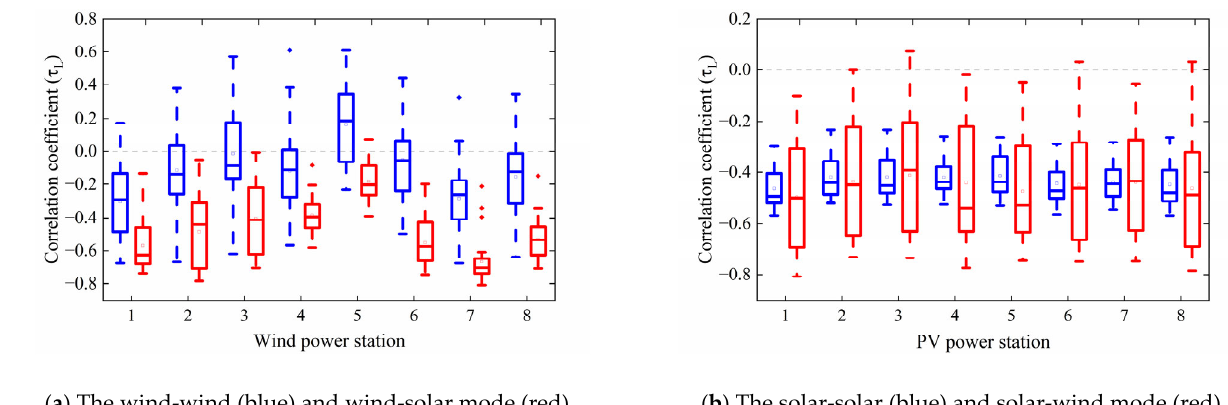
Figure 11. The fi rst type of complementary indicator of the WGAN-GP-generated data. Figure 11. The first type of complementary indicator of the WGAN-GP-generated data.